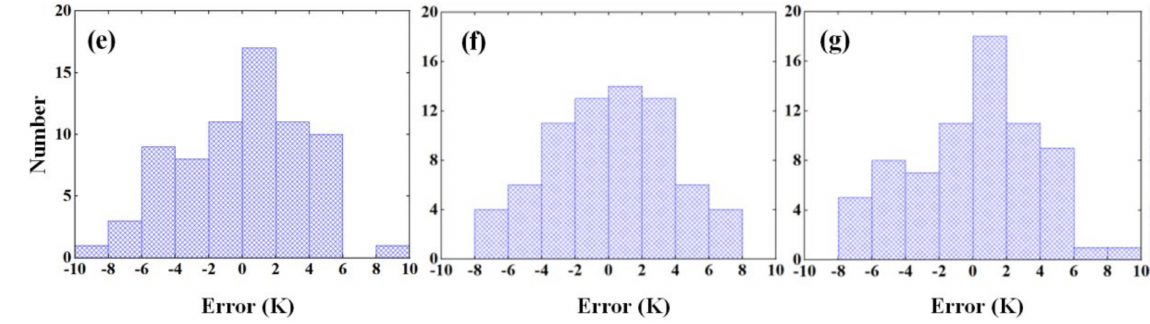
Figure 4. Scatter plot and error histogram of fused LST and measured LST. ( a ): Wetland station; ( b ): Gobi station; ( c ): Daman superstation; ( d ): All stations; ( e ): STARFM error histogram at All stations; ( f ): ESTARFM error histogram at All stations; ( g ): FSDAF error histogram at All stations.